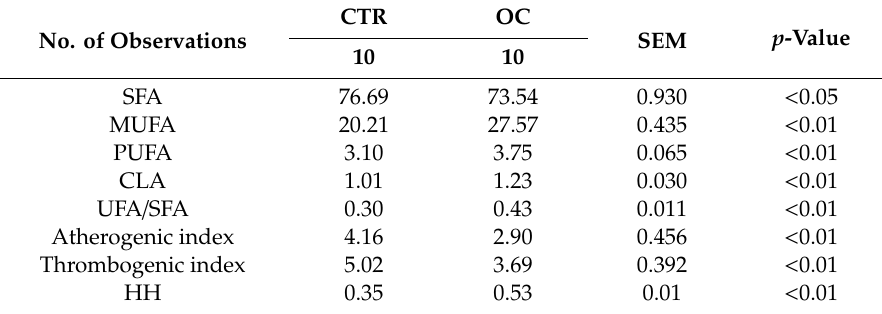
Table 8. Effect of olive cake supplement on cheese fatty acid classes (g/100 g) § and nutritional indices after 60 days of ripening.